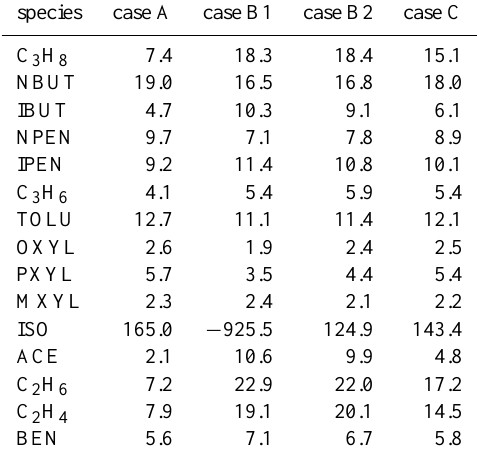
Table 7. For all species, the total emitted mass (in Gg) for the EMEP inventory run (case A), the a posteriori emissions under Gaussian assumption (cases B1 and B2) and the a posteriori emis- sions under the truncated Gaussian assumption (case